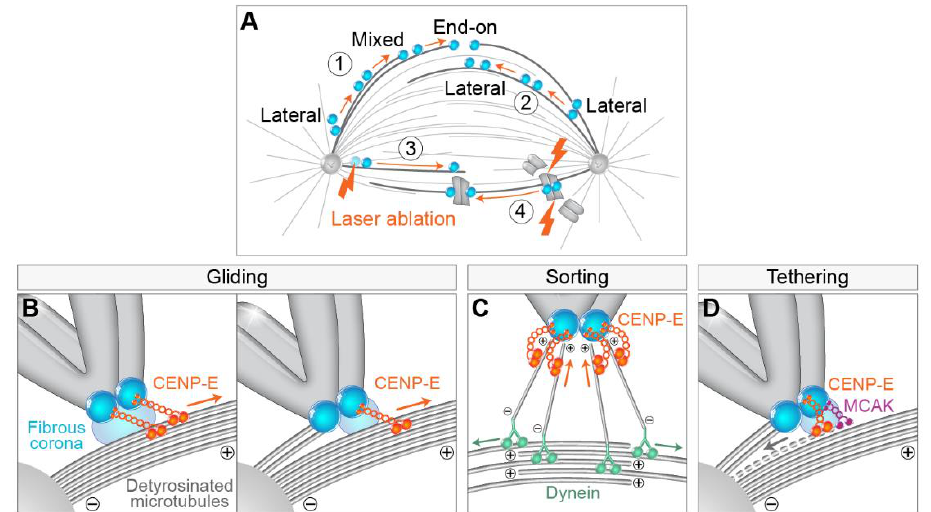
Figure 3. Main features and models of CENP-E-mediated chromosome congression to the spindle midplane. ( A ) (1) Congression of polar chromosomes to the equator involves the transition of lateral to end-on attachments of kinetochores (blue circles) to microtubules, (2) although congression is achievable by lateral-only interactions. Note that the sister kinetochores gradually change orientation to be parallel to the main spindle axis, and the interkinetochore distance gradually increases during congression in (1) and (2). (3) Both sister kinetochores and (4) chromosome arms are not prerequisites for congression. Orange arrows indicate congression movement over time. Lightning signs denote laser ablation of a specific structure. ( B ) Gliding model: Congression is facilitated by the CENP-E plus end directed walking and pulling laterally attached kinetochores (left) or mixed laterally/end- on attached sister kinetochores (right) toward microtubule plus end. Part of the centrosome is represented by the gray semicircle in the bottom left. ( C ) Sorting model: By walking towards the plus end, CENP-E sorts small kinetochore-nucleated microtubules in a way that their plus ends are oriented toward the kinetochore, while minus ends are connected to dynein, which facilitates their poleward-directed growth by walking along antiparallel microtubules toward their minus ends. ( D ) Tethering model: As the first step in end-on conversion, CENP-E is involved in the tethering of kinetochores to lateral surfaces of microtubules, while in the second step, MCAK is involved in the depolymerization (grey dashed line) and resolving of lateral microtubule attachments to kinetochores. The orange and green arrows in ( B – D ) represent the direction of motor movement, and the gray arrow represents the direction of microtubule